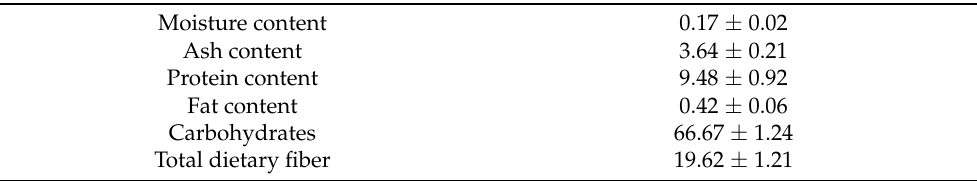
Table 1. Chemical composition of the extract obtained from PEF-treated artichoke